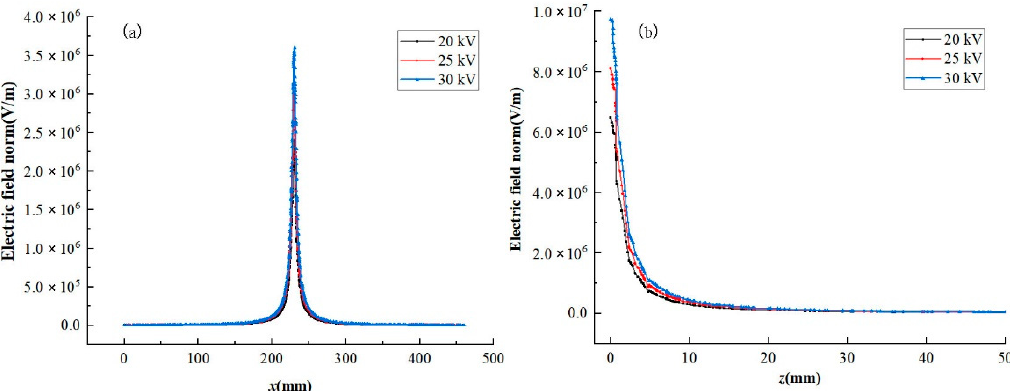
Figure 6. Electric field intensity of electrospinning setups for different voltages with a receiving distance of 150 mm; ( a ) electric field intensity along the x -axis at 2 mm below the needles and ( b ) electric field intensity along the z -axis.